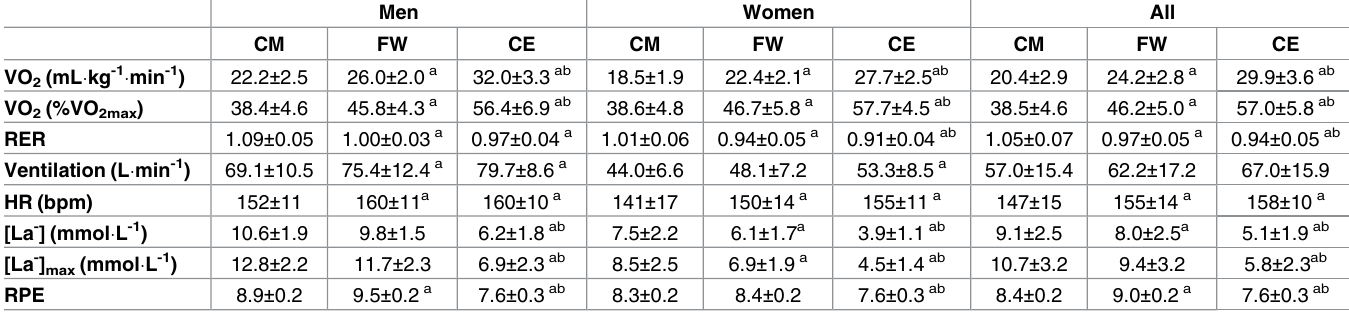
Table 2. Physiological parameters (mean ± SD) measured during Circuit Machine training protocol (CM), Free Weight training protocol (FW) and Combined Exercise training protocol (CE) in men (n = 15) and women (n = 14). Data correspondto the averageof the wholecircuit weight training (3 laps), except for [La - ] max